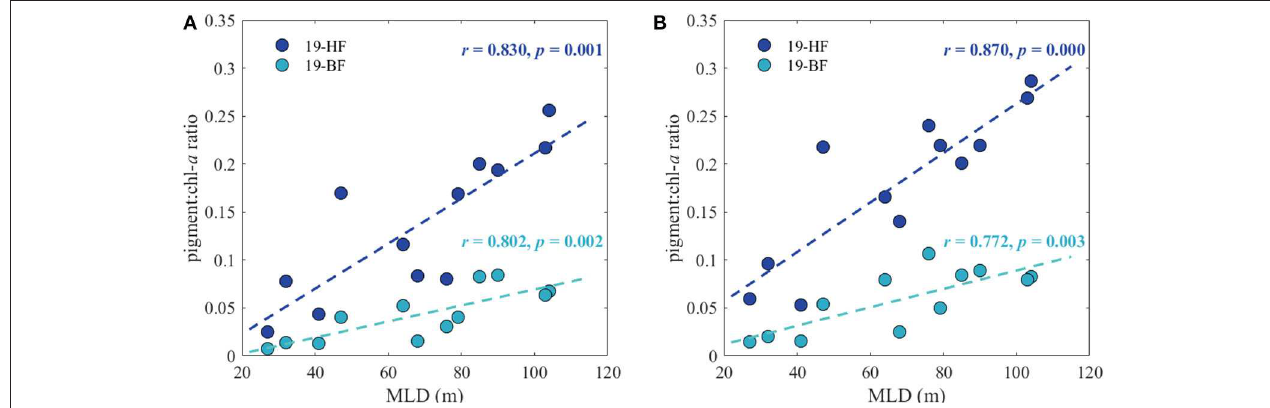
FIGURE 13 | Relation between mixed layer depth (MLD) and ratios between 19 ′ -hexanoyloxyfucoxanthin (19-HF), 19 ′ -butanoyloxyfucoxanthin (19-BF), and chlorophyll a concentration (chl- a ) in (A) the total and (B) < 20 µ m size fraction.